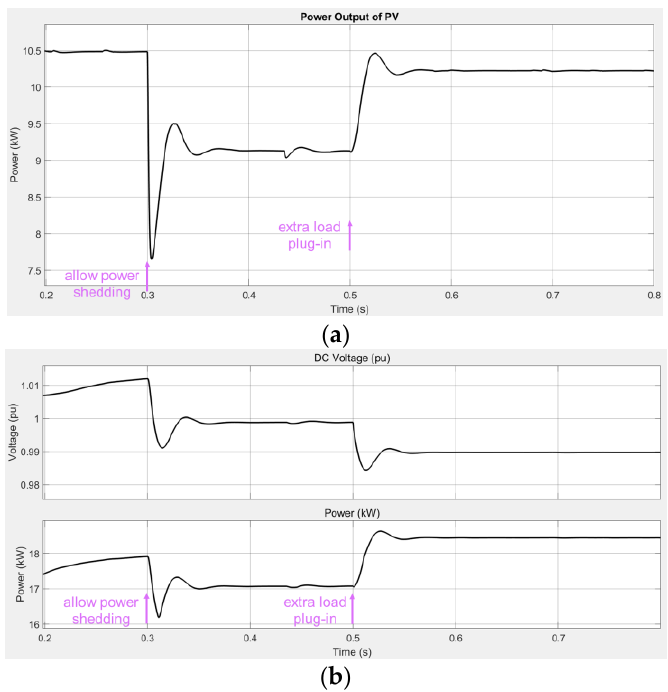
Figure 20. Voltage nadir measured in the Simulink simulation. ( a ) Power output of the PV generation; ( b ) Signals at DC bus.